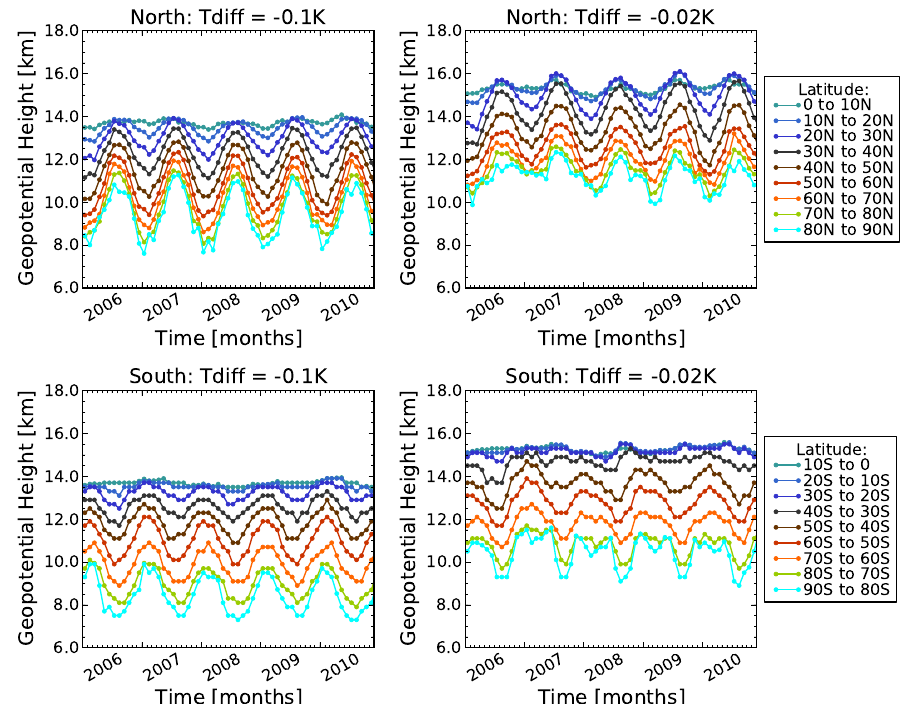
Figure 2. Temporal evolution of differences between dry and physical temperature ( T diff ) from 2006 to 2010, based on ECMWF mean climatological fields. The left column shows the temporal evolution of T diff = − 0 . 1 K, while the right column shows T diff = − 0 . 02